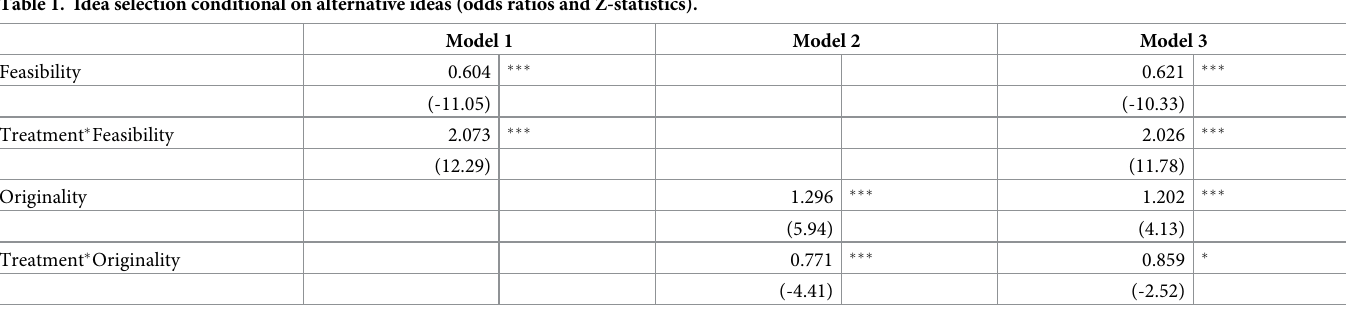
Table 1. Idea selection conditional on alternative ideas (odds ratios and